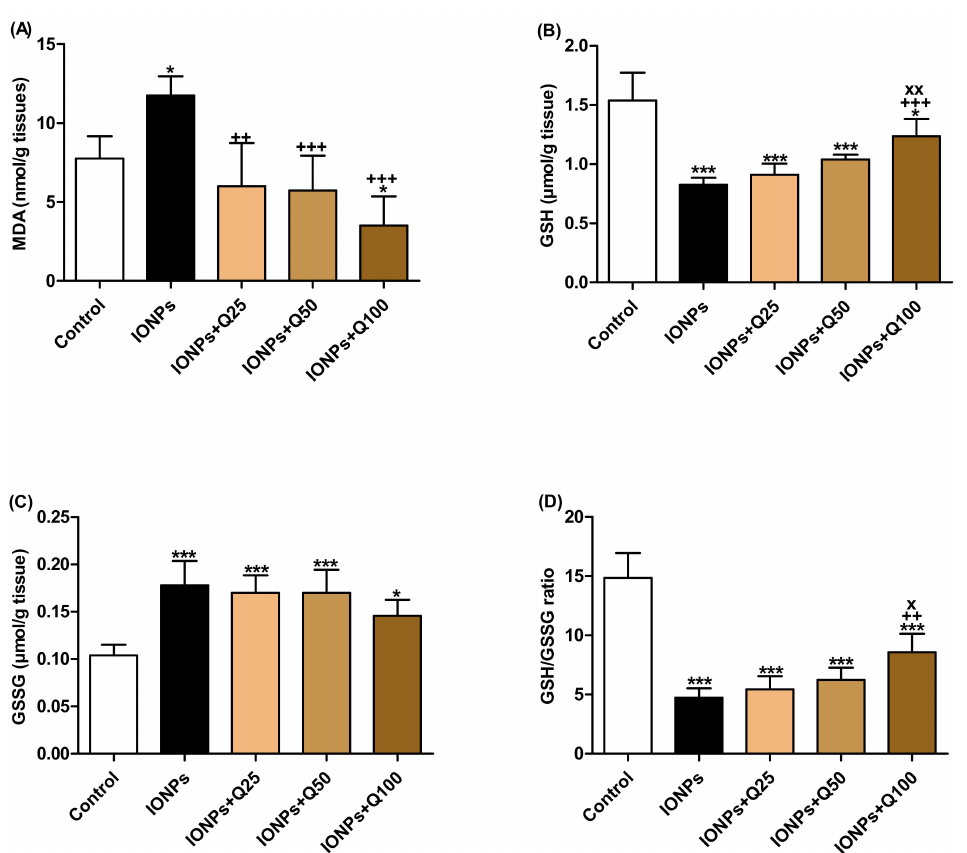
Figure 3. The oxidative stress and anti-oxidant status of brain tissues. ( A ) Malondialdehyde (MDA) (nmol/g tissues). ( B ) Glutathione (GSH) ( µ mol/g tissue). ( C ) Oxidized glutathione (GSSG) ( µ mol/g tissue). ( D ) GSH/GSSG ratio. Data were analyzed with a one-way ANOVA followed by Tukey’s multiple comparison test. * p < 0.05 and *** p < 0.001 vs. the control. ++ p < 0.01 and +++ p < 0.001 vs. IONPs. x p < 0.05 and xx p < 0.01 vs. IONPs + Q25. Error bars represent mean ± SD. n = 5. White color column refers to control. Black color column refers to IONPs. Colored column with different extents refers to different concentrations of quercetin supplementations to IONPs-treated